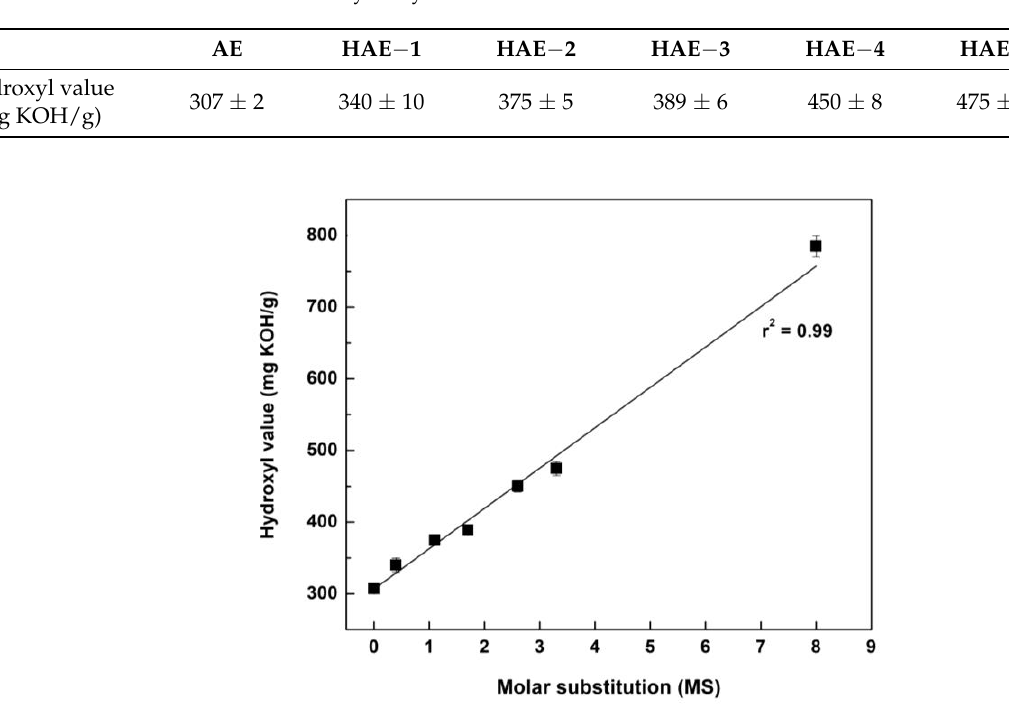
Table 5. Hydroxyl values of AE and HAEs.